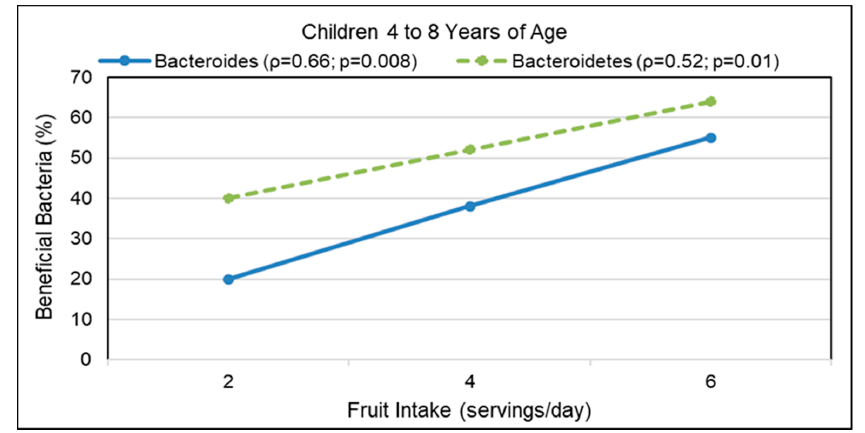
Figure 2. Correlations between daily servings of fruit intake and the microbiota abundance of beneficial Bacteroides and Bacteroidetes in children [51].